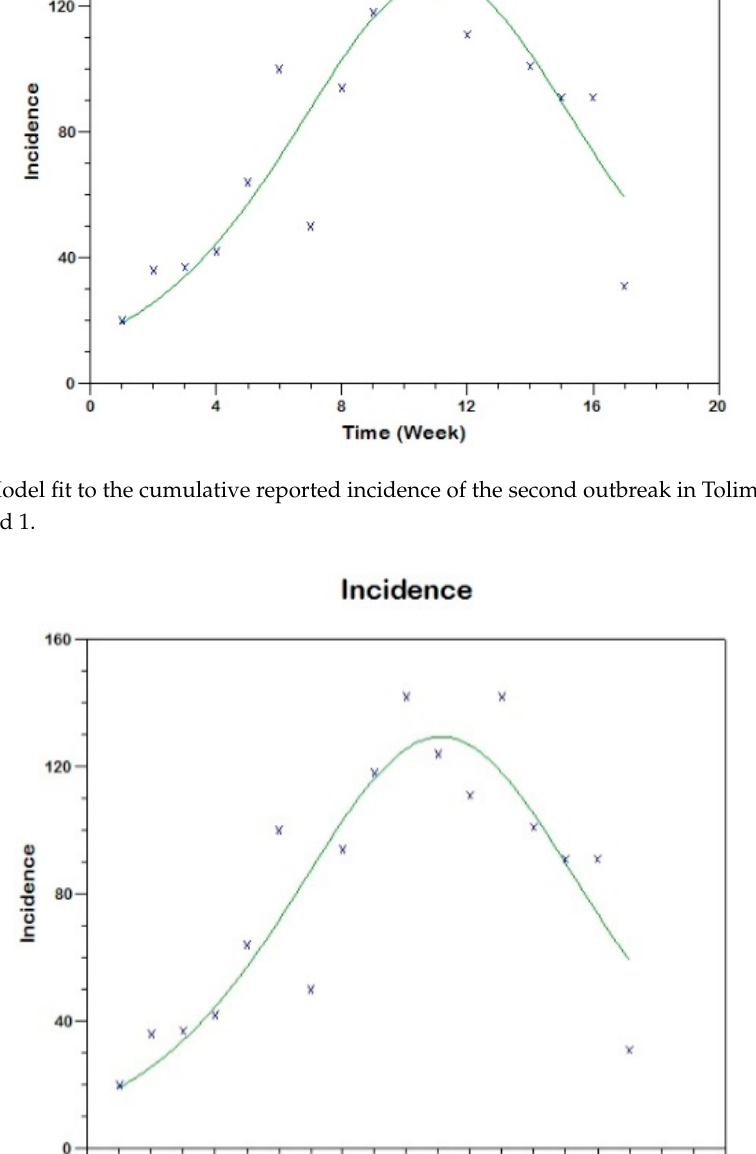
Figure 15. Model fit to the cumulative reported incidence of the second outbreak in Tolima-Colombia using Method 2. Table 6. Model parameter estimates for Tolima, Colombia (second outbreak).